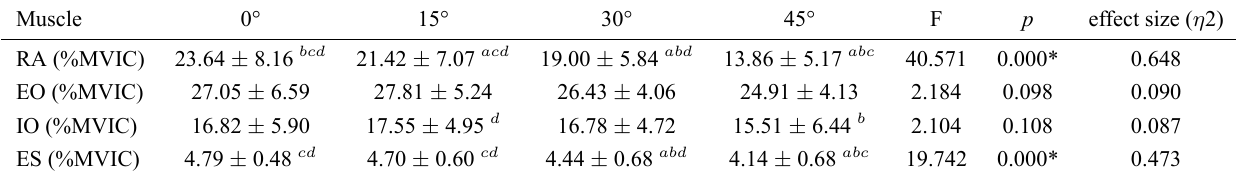
Table 3. Comparison of muscle activity on trunk muscles according to hip abduction angle.